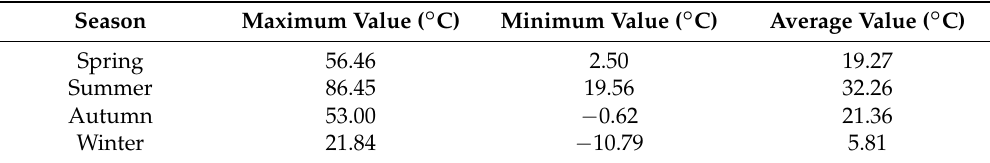
Table 1. Conductor temperatures in different seasons.